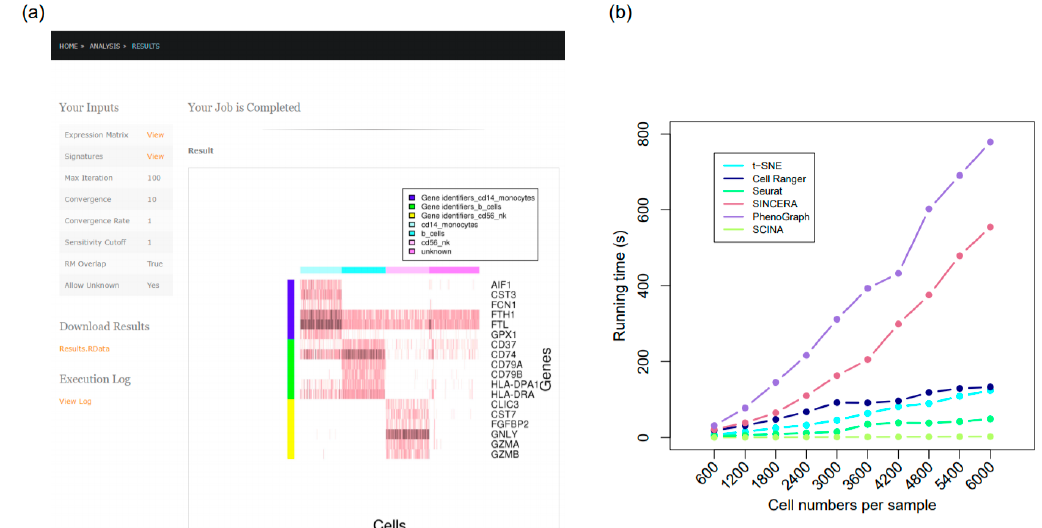
Figure 7. The SCINA R package and web server. ( a ) Screenshot of the SCINA web server. ( b ) Runtime comparison for SCINA, Cell Ranger (K-means clustering mode with graph-based fine-tuning), t-SNE, Seurat, SINCERA, and PhenoGraph. Runtime tests were performed on 10 datasets, constructed with 280n randomly selected HEK293 cells (out of 2885 total cells) and 320n randomly selected Jurkat cells (out of 3258 total cells), where n was an integer ranging from 1 to 10. Both HEK293 cell and Jurkat cell sets were publicly available from Zheng et al [2].